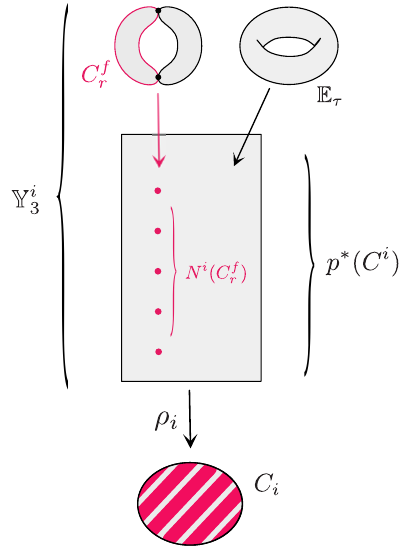
Figure 3 . This figure shows the component of the matter curve Σ r (drawn in red) along a base curve C i . It refers to a geometry where the fourfold Y 4 is fibered over C i with generic fiber Y i The issue is to determine the multiplicity N i ( C f picture we see that it coincides with the number of points on Y i degenerates. The remaining components of Σ r in the decomposition (3.30) lie within special fibers of the fibration ρ i (3.23) and are not